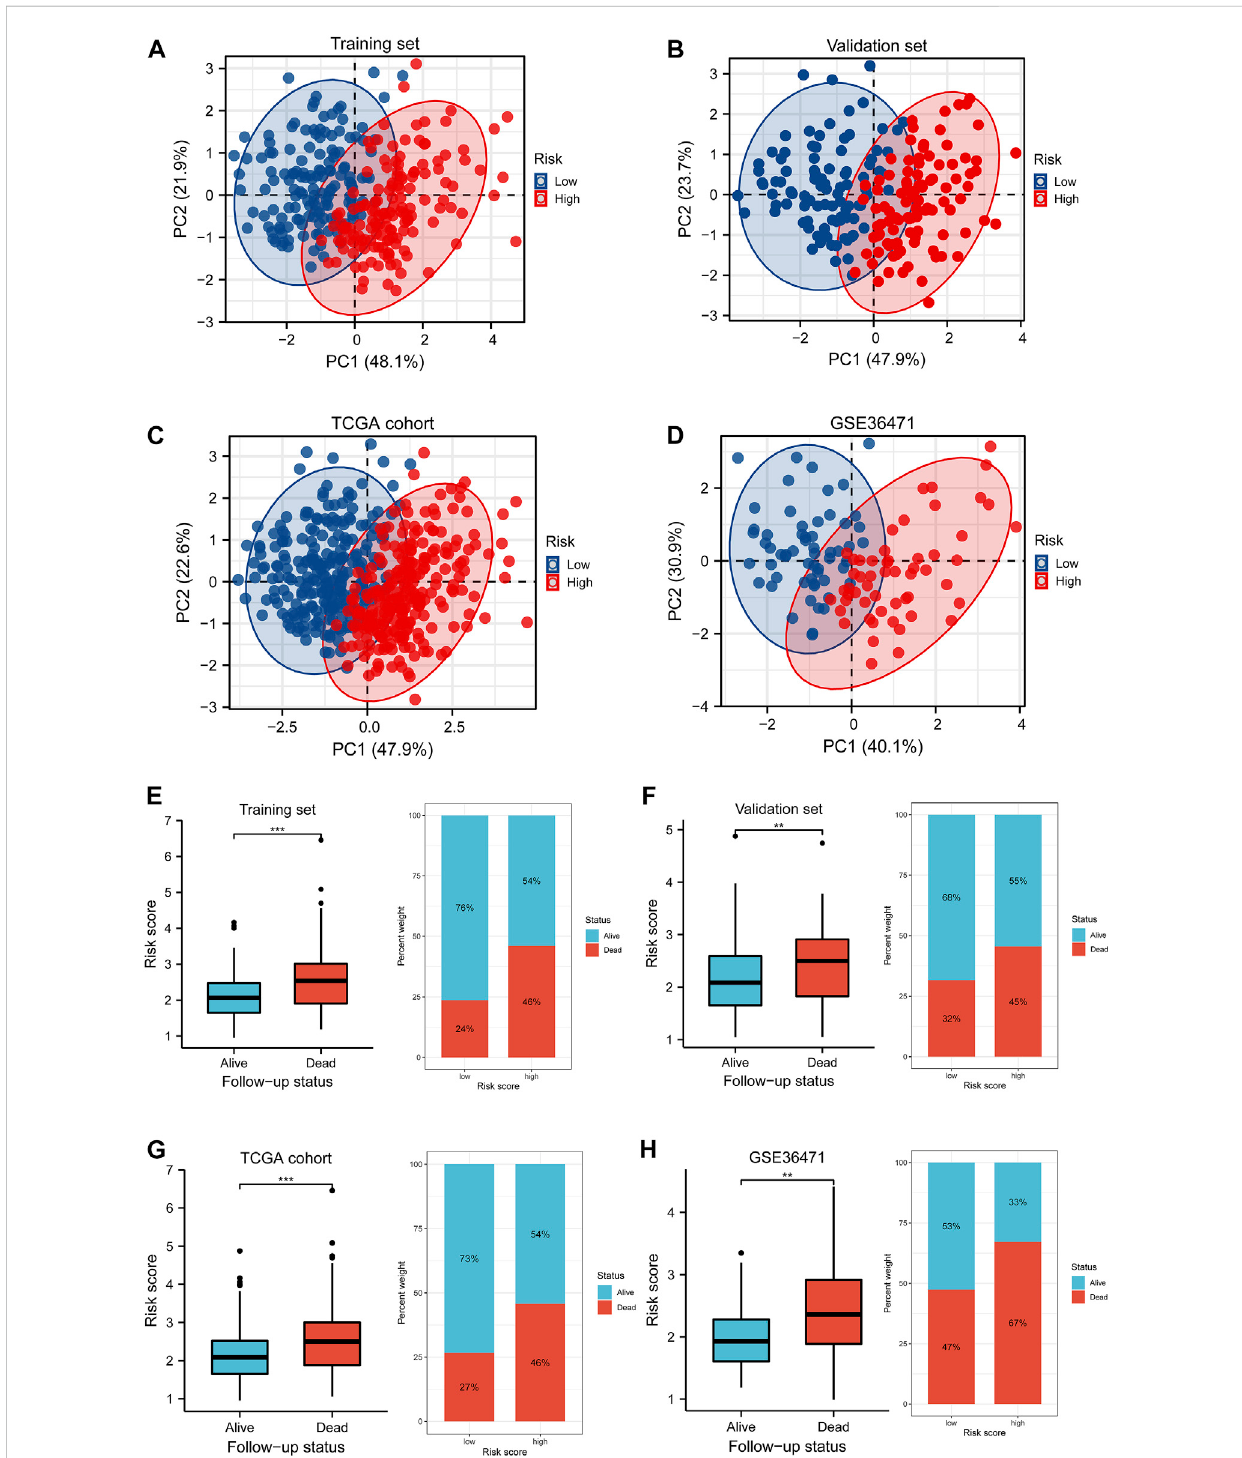
FIGURE 6 PCA and differences of the survival status with the risk score. (A – D) Distributions of low- and high-risk patients in the PCA for the training set, validationset,TCGAcohort,andGSE36471dataset.Thenumberinthebracketsrepresentedtheratioofexplainingvariabilityofthewholedata. (E – H) The Wilcoxon rank-sum test implied the variations of risk scores between the alive and dead follow-up status in the training set, validation set, TCGA cohort, and GSE36471. PCA: principle component